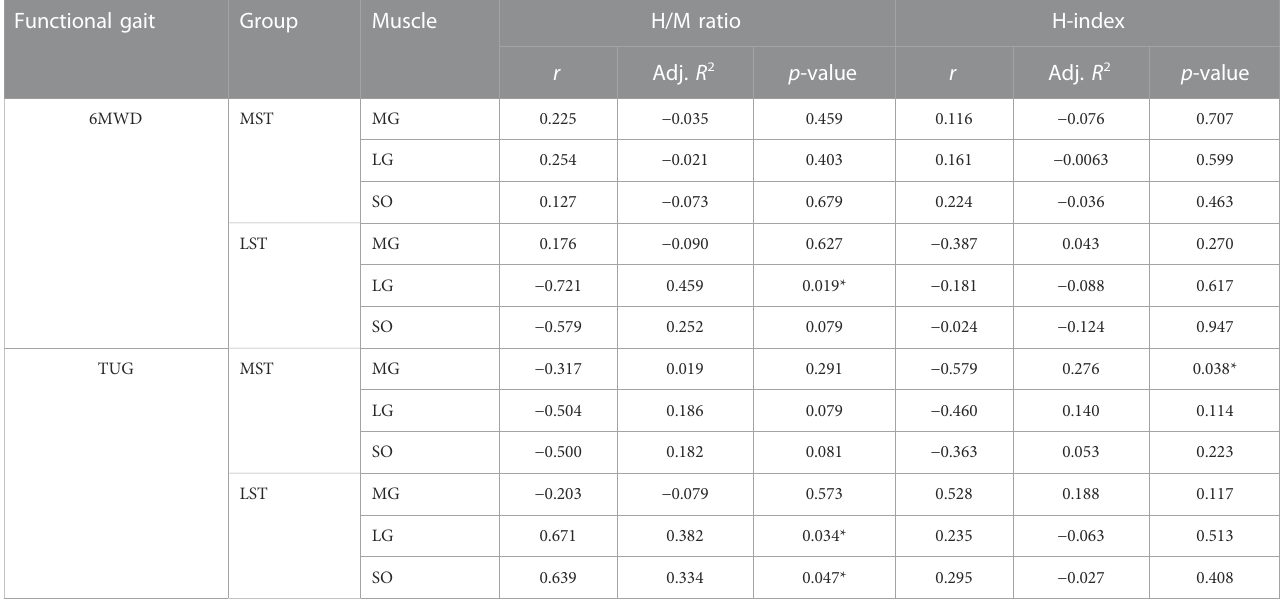
TABLE 2 The linear correlation between H-re fl ex parameters of (H/M ratio and H-index) of the triceps surae during standing and functional gait (6MWD & TUG) in respective groups. Functional gait